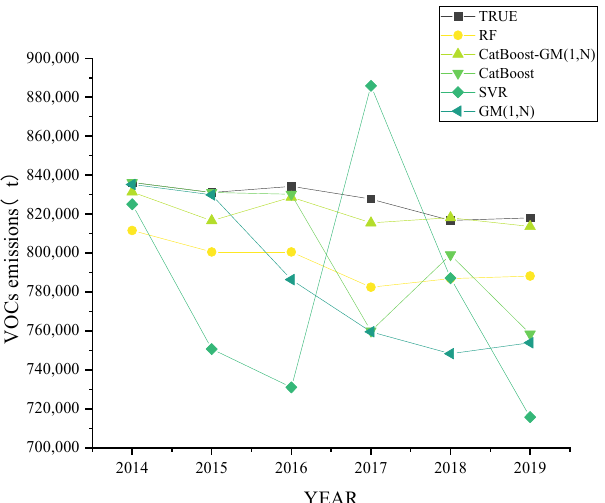
Figure 2. Projected building industry VOCs emissions by province and city in China from 2014–2019 for six models.